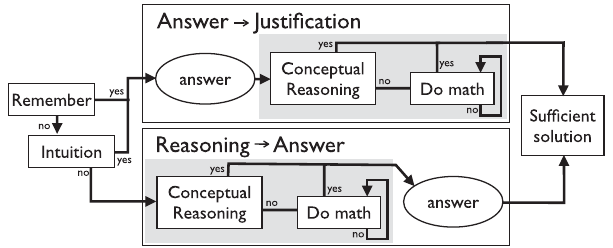
FIG. 1. The answer-making e-game. Upper box: Answer leads to Justification (AJ) path. Lower box: Reasoning leads to Answer (RA) path. Shading indicates the justification and reasoning